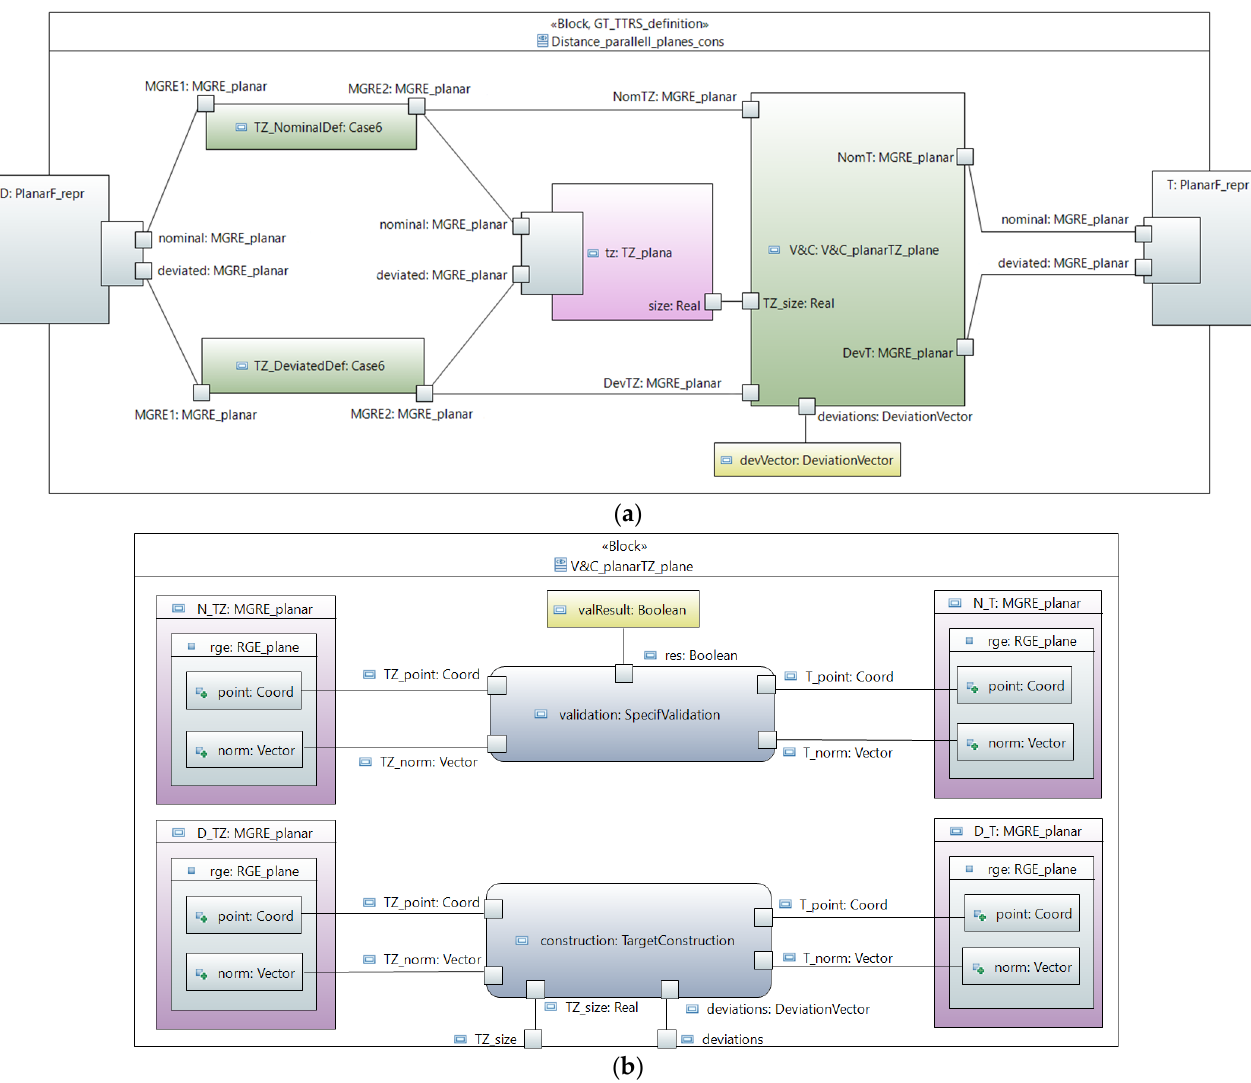
Figure 12. ( a ) IBD diagram of the Distance_parallell_planes_cons Block; ( b ) PAR diagram of the V&C_planarTZ_plane block.